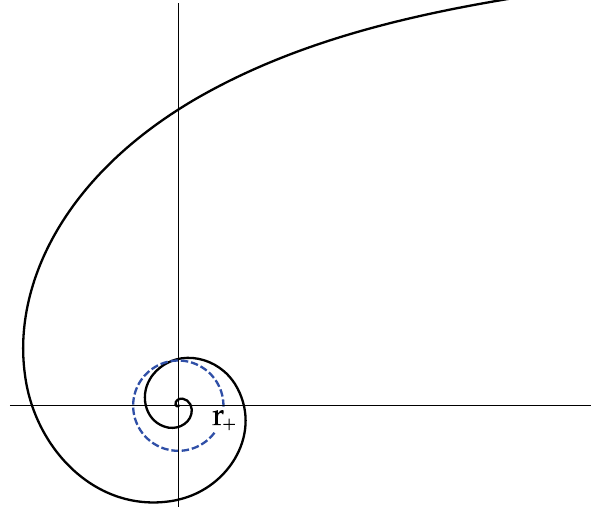
Fig. 6 Polar plot for the unbounded trajectory, Eq. (40), followed by photons whose impact parameter lies between 0 < b < b